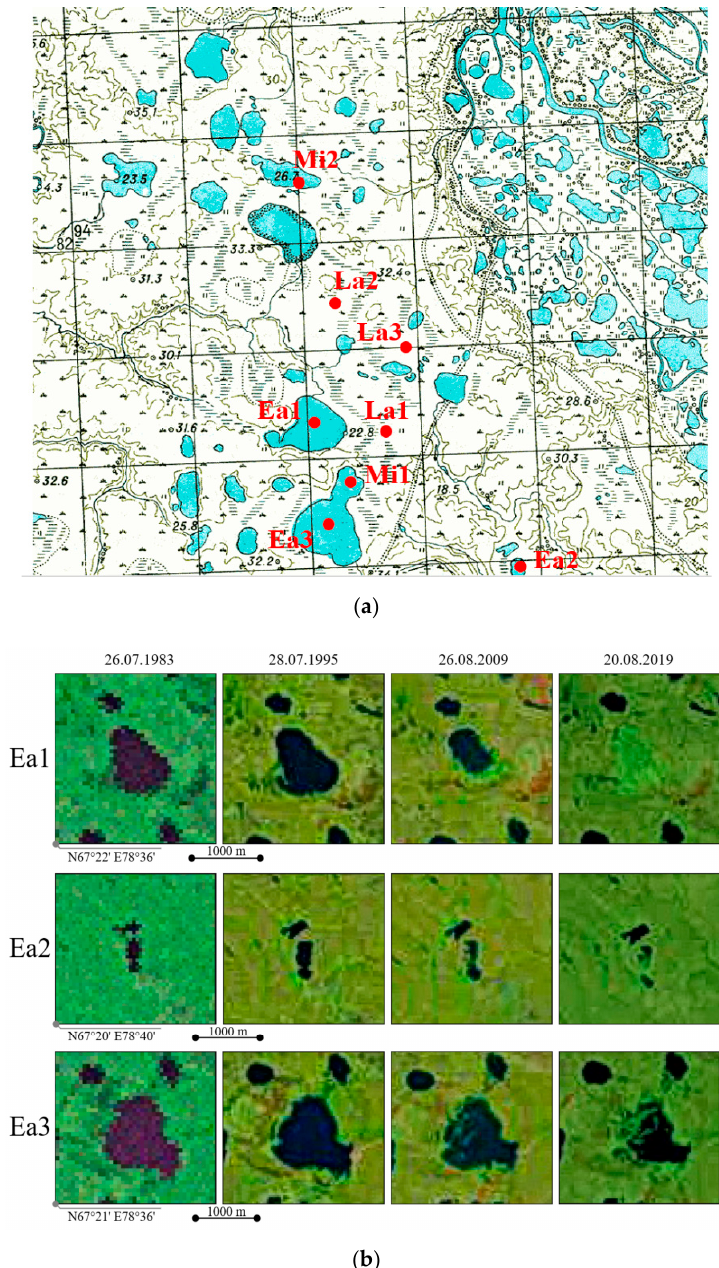
Figure 14. Map of the Tazovsky key site of the late 40 s ( a ) and satellite images of Landsat 3–7 with early khasyrey ( b ).